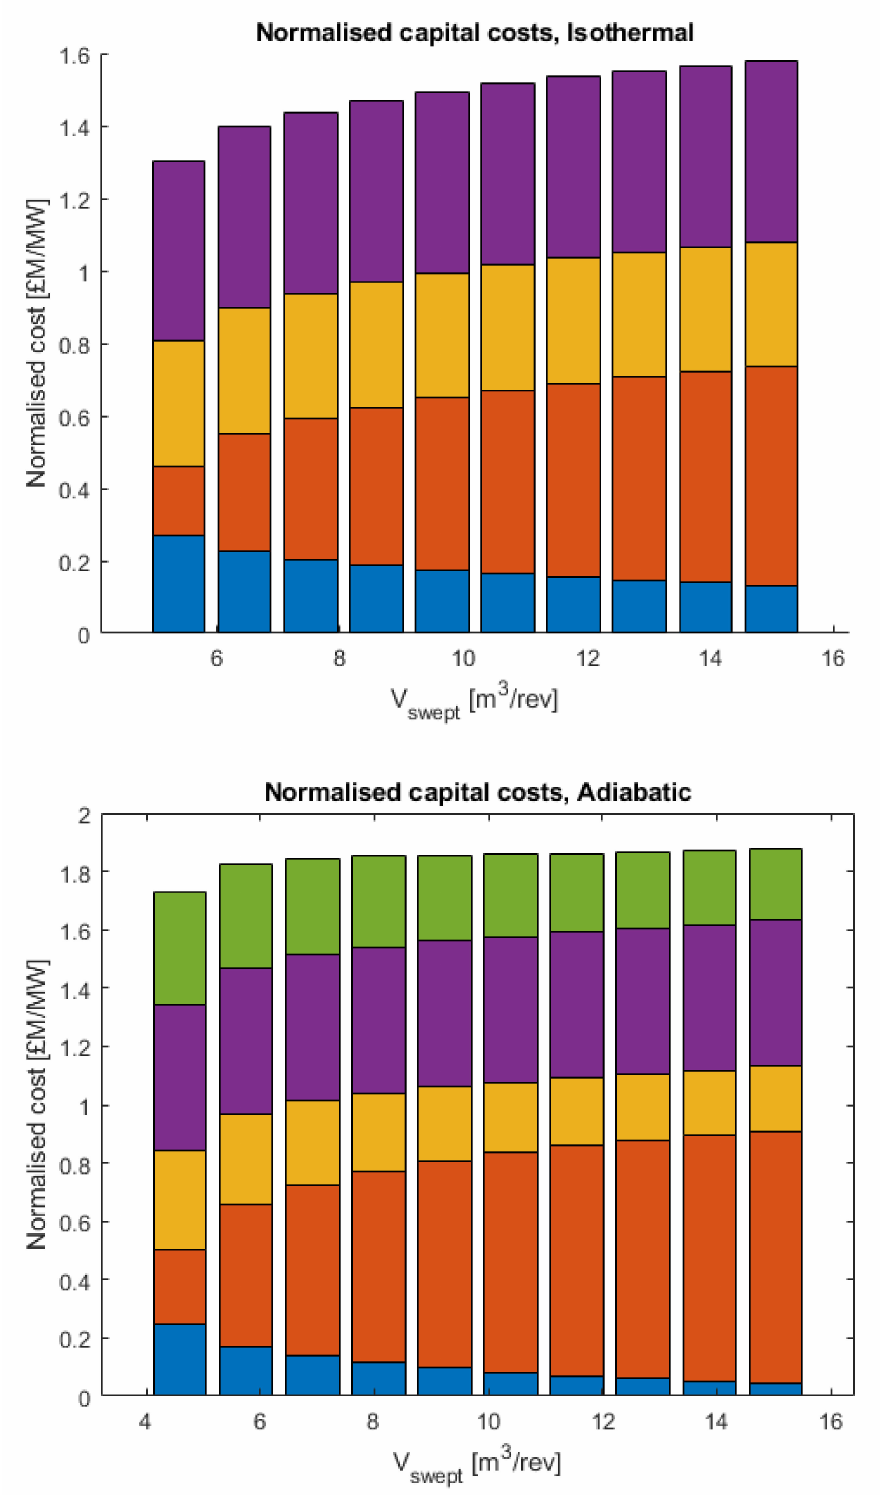
Figure 12. Breakdown of capital costs shown in Figure 10, normalised by the total discharge power of the system. Isothermal ( above ) and adiabatic ( below ) configurations